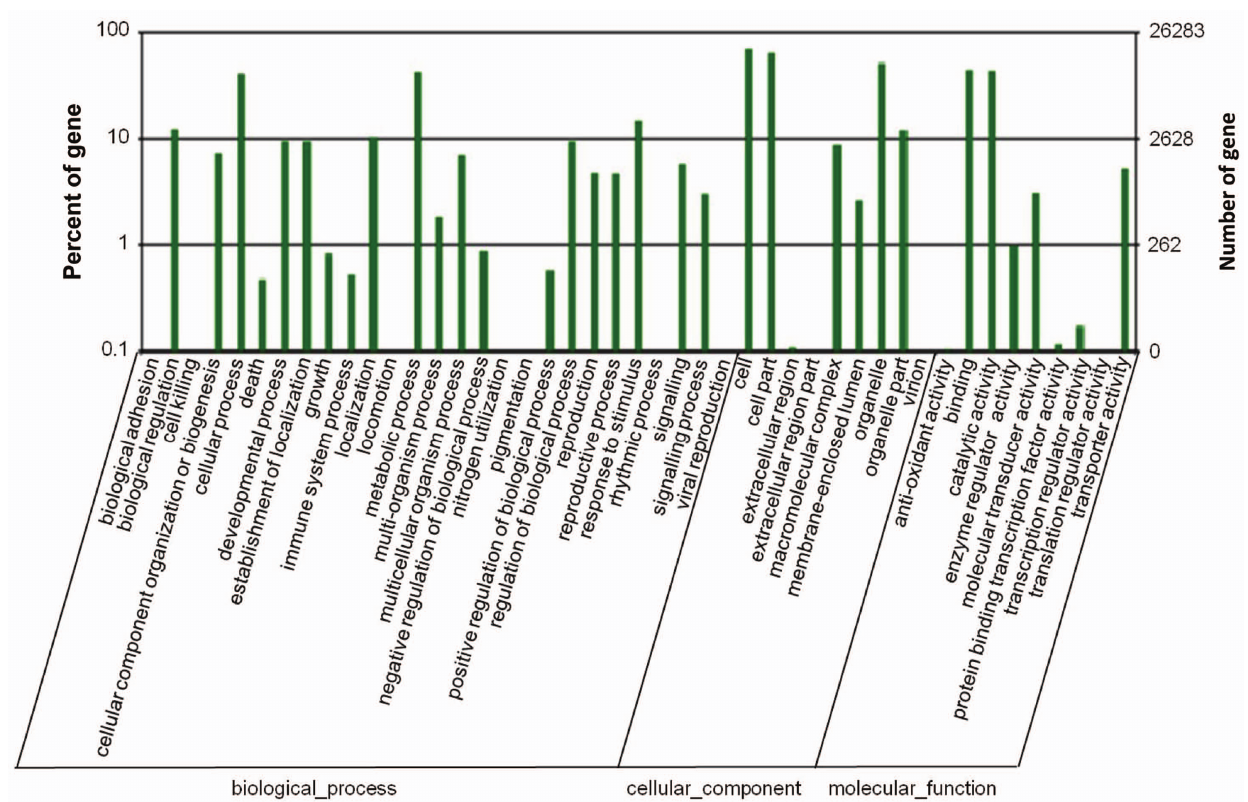
Figure 3. GO function analysis of unigenes from cotton embryo axis and cotyledon. GO terms include ‘‘biological process’’, ‘‘cellular component’’ and ‘‘molecular function’’, of which, each was made up of different number of subclasses. The value from the right Y axis of ordinates shows the number of unigenes were classified into each subclass, and the percentage of the number of unigenes from each subclass in the total quantity of unigenes classified into the corresponding term was indicated by the value from the left Y axis of